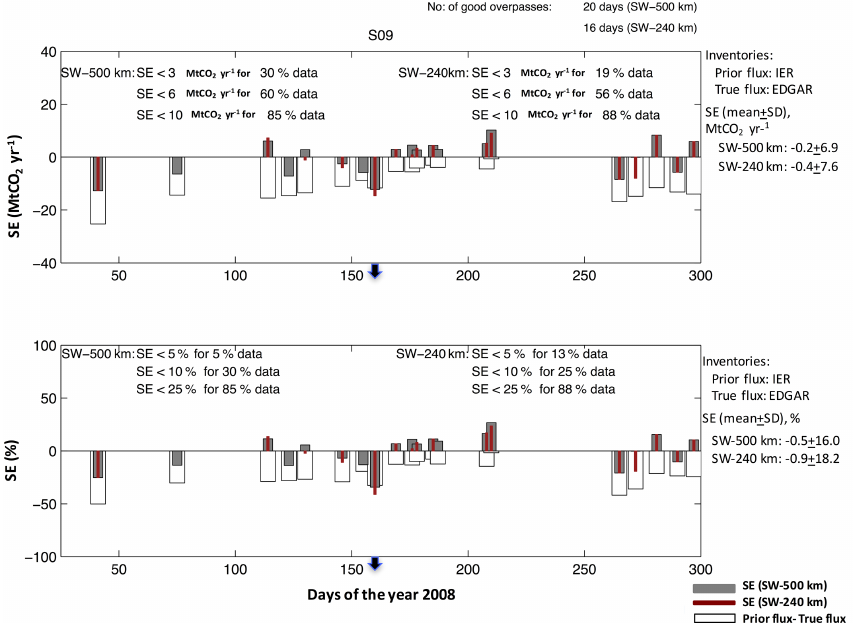
Figure 12. Similar to Fig. 9, but for the inversion experiment S09 using IER (a priori) and EDGAR (true) emission